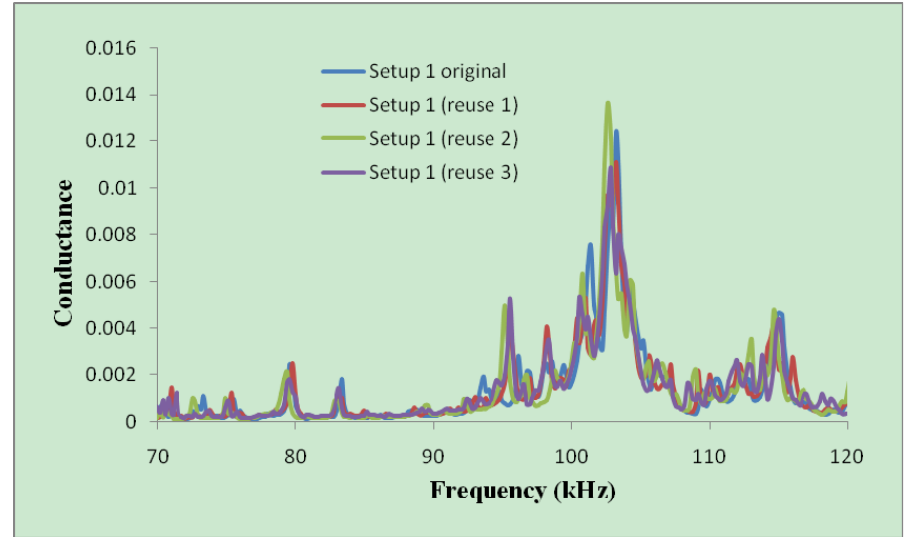
Figure 8. Initial signatures obtained from setup 1a at initial condition and after removing from samples.